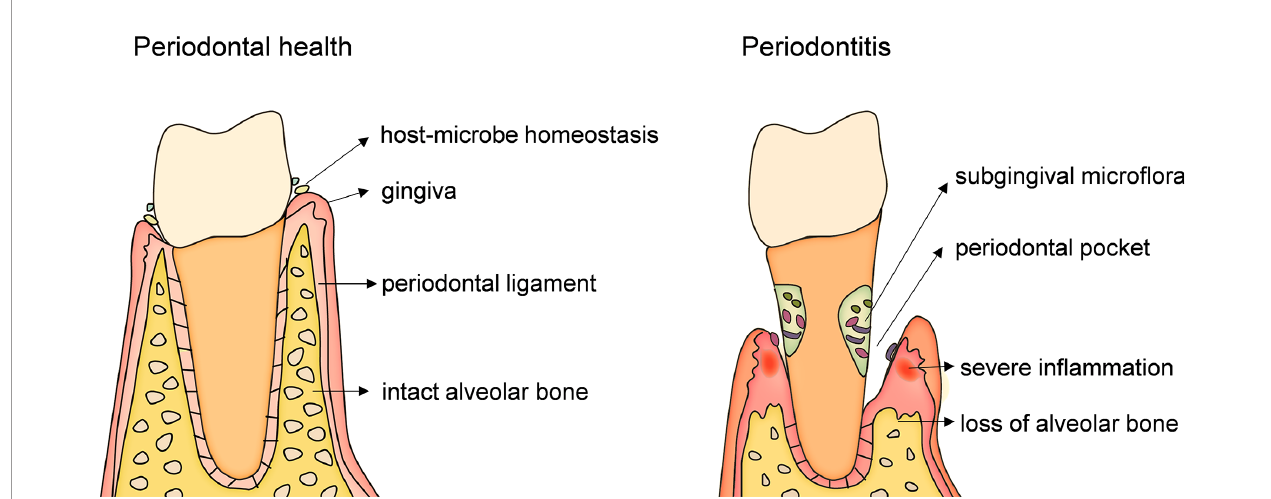
FIGURE 1 | An anatomical illustration of periodontitis. caused by infection of microbial from dental plaque bio fi lm. Pathogenic microorganisms and their products act on gingiva for a long time and cause immune response which fi rst leads to gingival in fl ammation. When in fl ammation spreads to the deep periodontal tissue, causing the dissolution and destruction of collagen fi bers in the gingiva and periodontal ligament and absorption of alveolar bone, resulting in the formation of periodontal pocket, which is the occurrence of periodontitis. The main symptoms of periodontitis are in fl ammation and bleeding of gums, formation of periodontal pockets, loss of alveolar bone, loosening and loss of teeth.